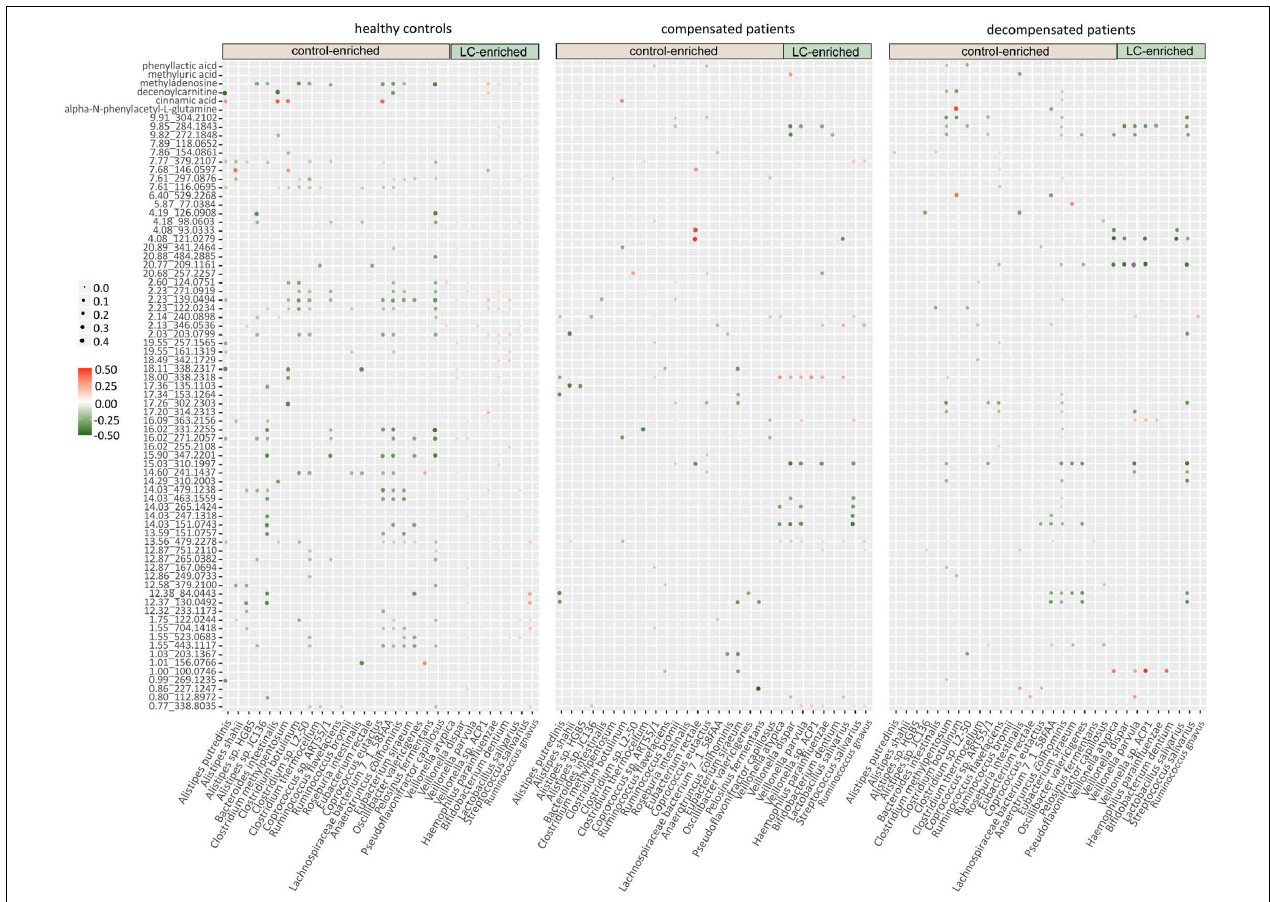
FIGURE 4 | Heatmaps of correlations between the gut microbiome and urine metabolites in healthy controls, compensated and decompensated